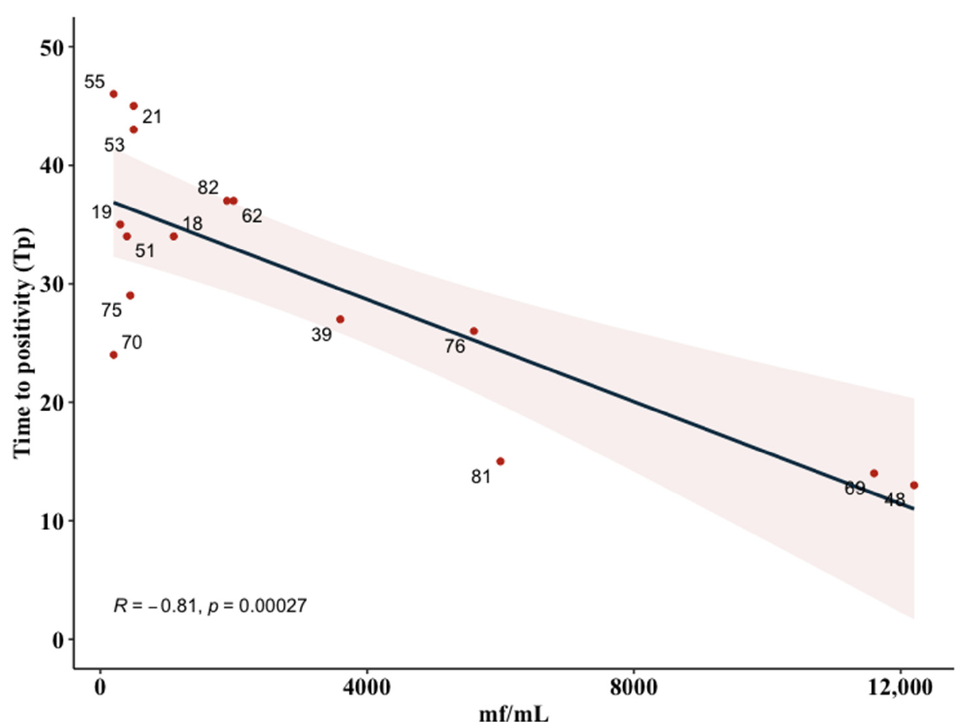
Figure 3. Correlation chart showing the relationship between time to positivity (Tp) values and microfilariae per milliliter (mf/mL) for the 16 samples microscopically positive for Loa loa that also tested positive for Loa loa in real-time LAMP assays. The numbers associated with the red dots indicate the number of the samples analyzed.